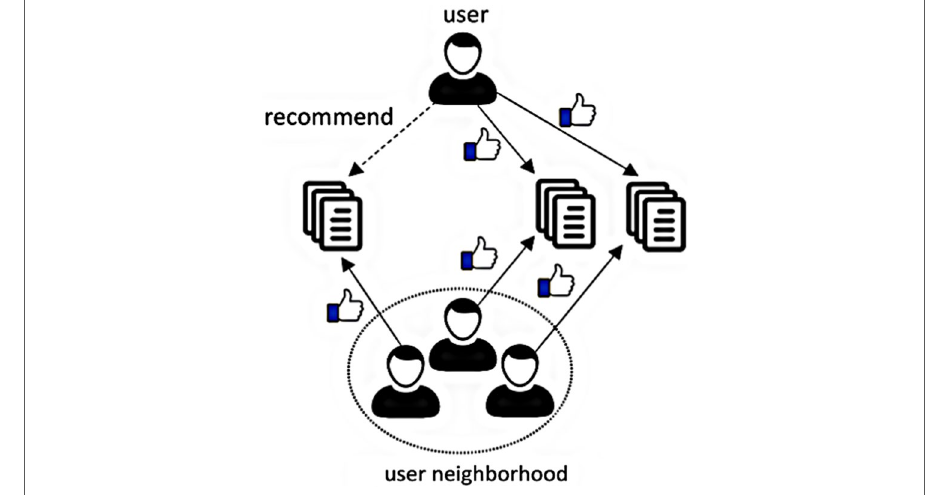
Fig. 3 User-based collaborative filtering